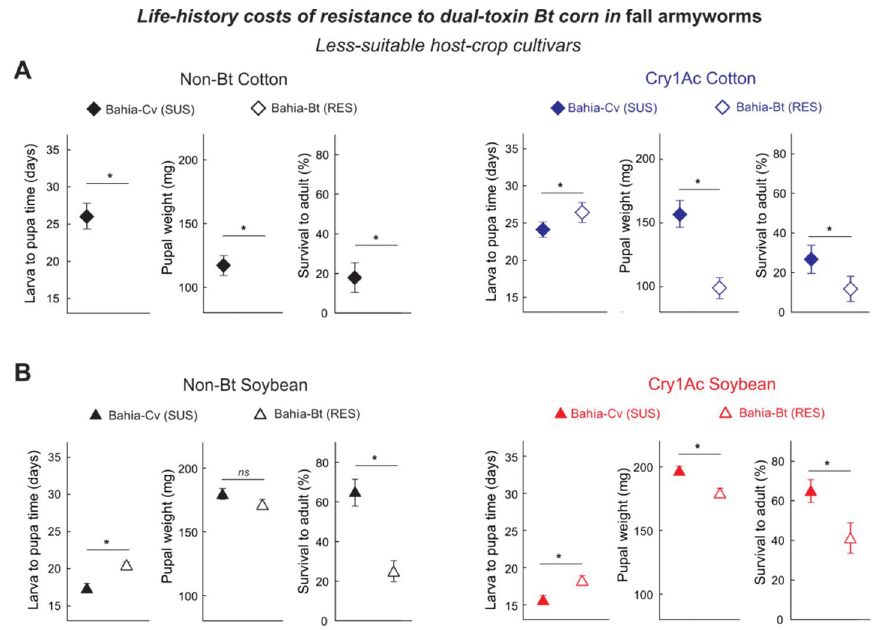
Figure 2. Influence of less-suitable host plants on the life-history costs of resistance to dual-gene Bt maize (Cry1A.105+Cry2Ab2) in the invasive fall armyworm ( Spodoptera frugiperda ). Larvae ( n = 160) of a Bt-resistant population (Bahia-Bt, black symbols) and susceptible population (Bahia-Cv, white symbols) were reared on the foliage of cultivars of ( A ) cotton and ( B ) soybean, and their life-history traits were recorded. Data are means ± standard errors. Asterisks indicate significant differences (ANOVA, p < 0.05) between the insect populations. ns: Not Significant.